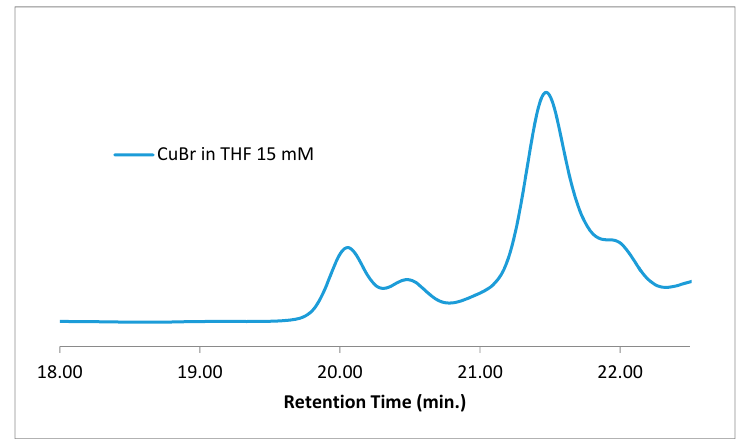
Figure 7. GPC trace of results for CuBr and THF, with all other reactants absent, stirred at 60 ◦ C for 24 h with [CuBr] at 15 mM. The reaction mixture was concentrated under reduced pressure and analyzed by GPC. Note: if the mixture was analyzed prior to heating, no poly(THF) was